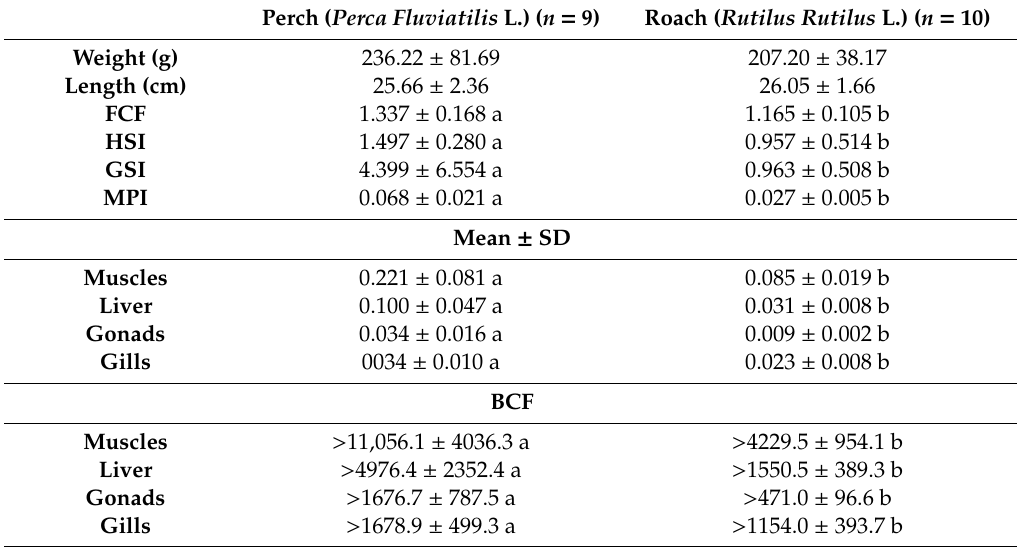
Table 1. Biometric parameters, BCF and di ff erences between the content of mercury in the same organs of fish examined (mg / kg wet weight). Perch ( Perca Fluviatilis L.) ( n = 9) Roach ( Rutilus Rutilus L.) ( n = 10) Weight (g) 236.22 ±